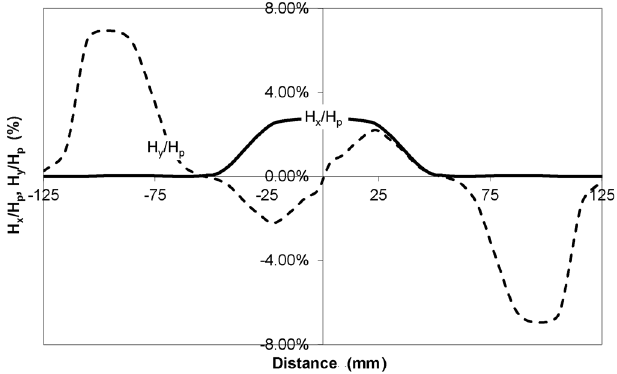
TUPB025.FIG. 11. MWS H -field distribution along the axis of the 150 MHz